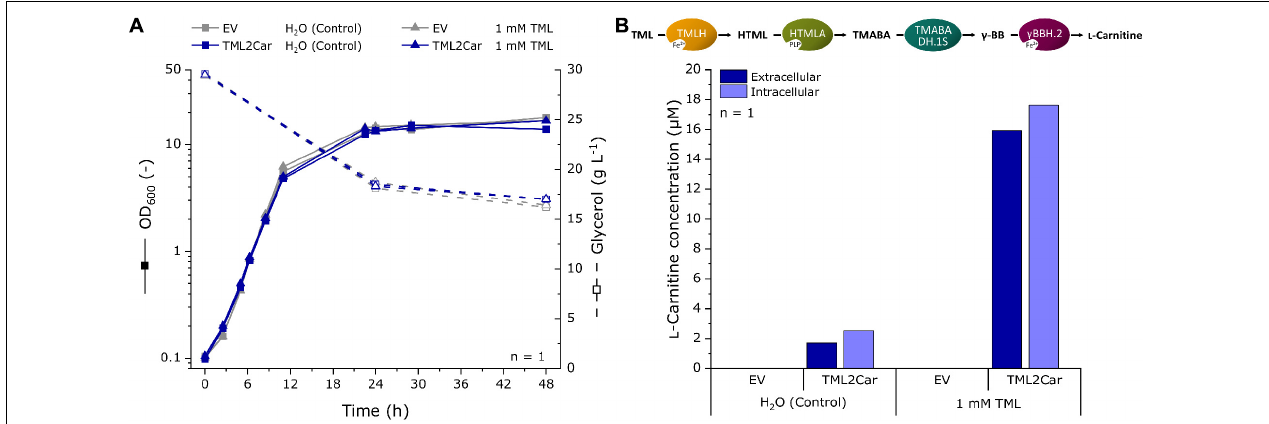
FIGURE 6 | Fermentation for L -carnitine production in modified M9 minimal medium with supplementation of 1 mM TML or water as a control using recombinant E. coli expressing the L -carnitine biosynthetic pathway from N. crassa. The pathway was expressed in E. coli BW25113 (cid:49) cai-fix from plasmid pTrc99A-TML2Car. The empty vector (EV) pTrc99A was used as control. (A) Growth curve and residual glycerol concentrations of the fermentation experiment. (B) LC-MS analysis of the extracellular and intracellular L -carnitine concentration at the end of the cultivation after 48 h. L -carnitine was identified by its mass to charge ratio ( m/z ) of 162.11247. The detection limit was 0.5 µ M. Intracellular concentrations were determined from the L -carnitine concentration in cell pellet extracts and the calculated total cell volume of the